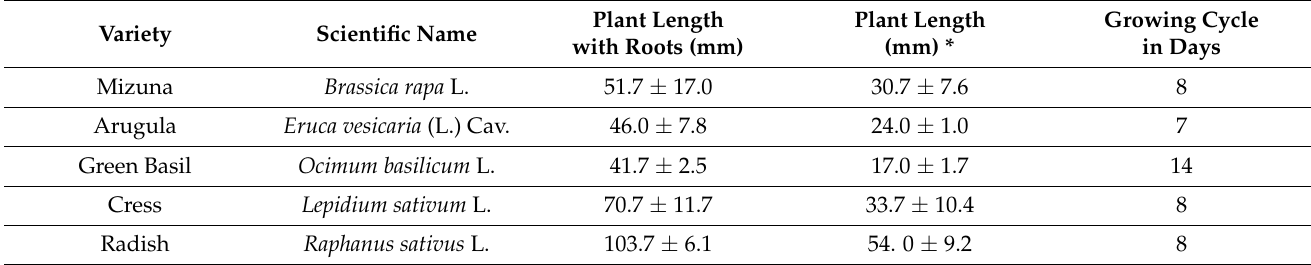
Table 1. Quantitative parameters and growing cycle of microgreen species.